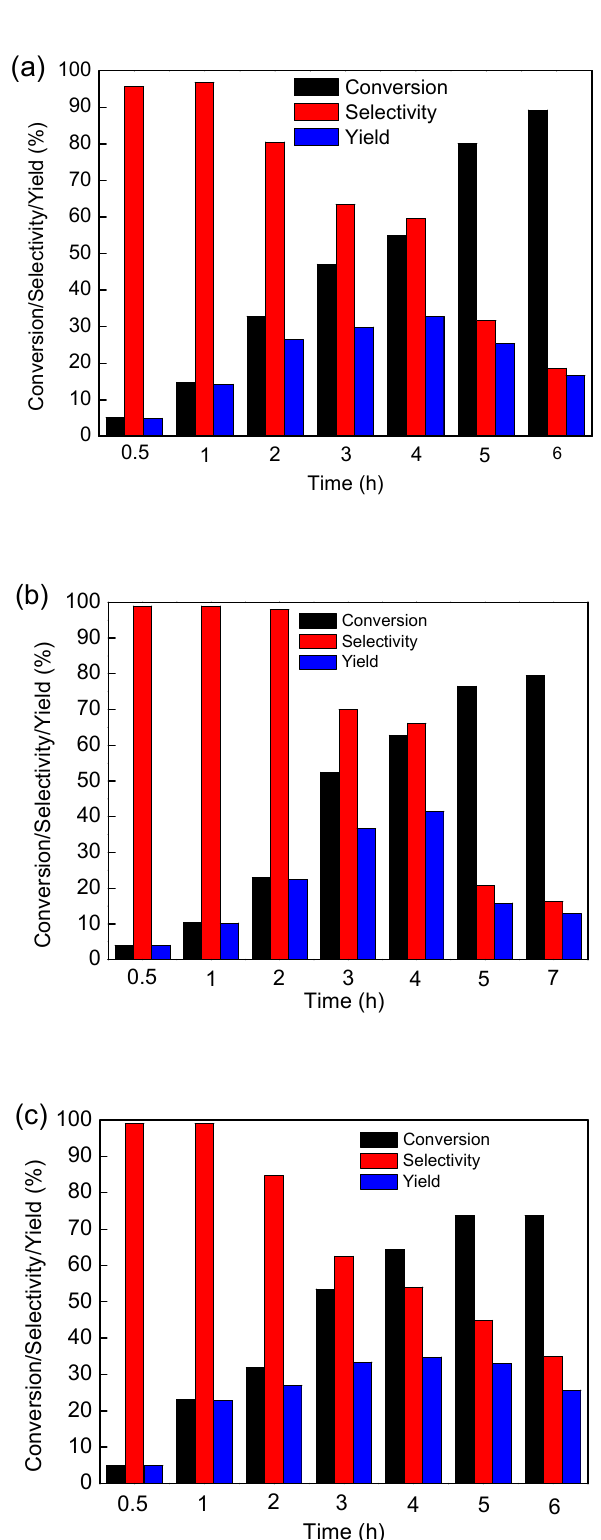
Figure 7. The oxidation of benzyl alcohol with the reaction time of the catalysts: ( a ) CuNi/TiO 2 ; ( b ) CuNi/MIL-101; ( c ) CuNi/C (reaction condition: benzyl alcohol (0.2 mmol), THF (1.5 mL), catalyst (40 mg), 100 °C, 5 bar).